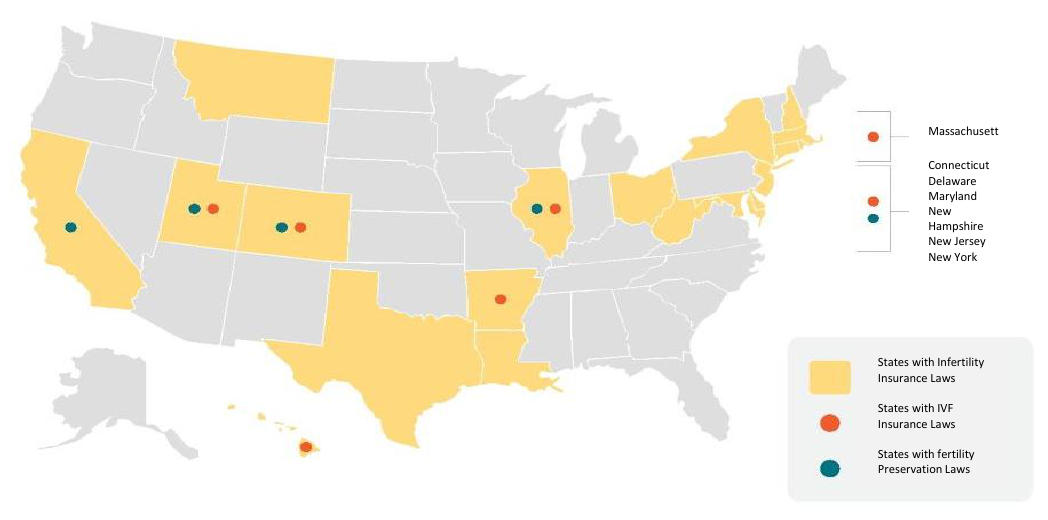
Figure 1: Infertility Coverage per State. Retrieved and adapted from https://resolve.org/what-are-my-